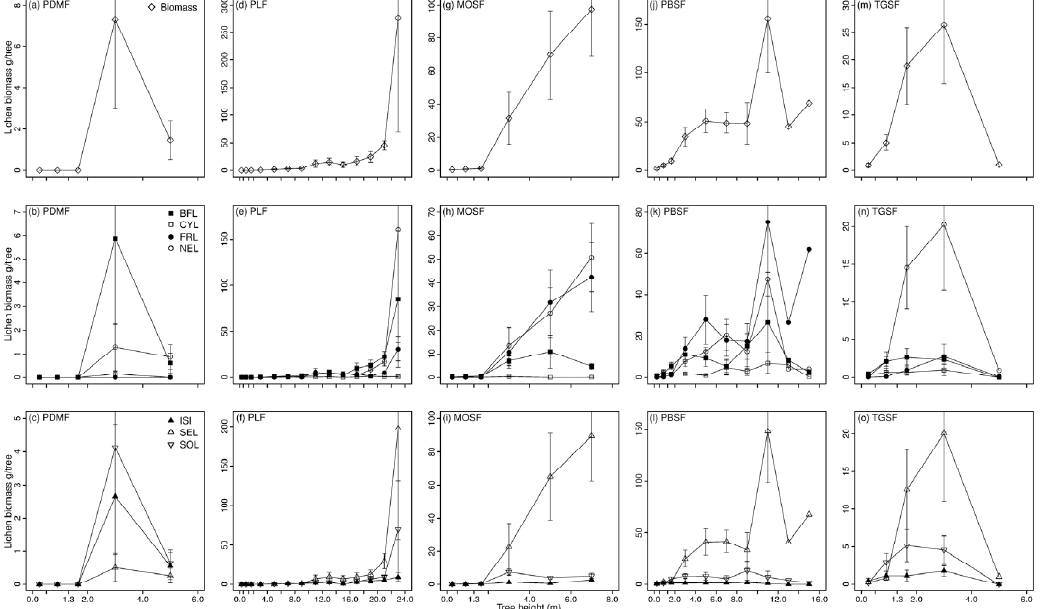
Figure 4. The biomass of epiphytic lichens at each height segment in five forest types ( a – c : the